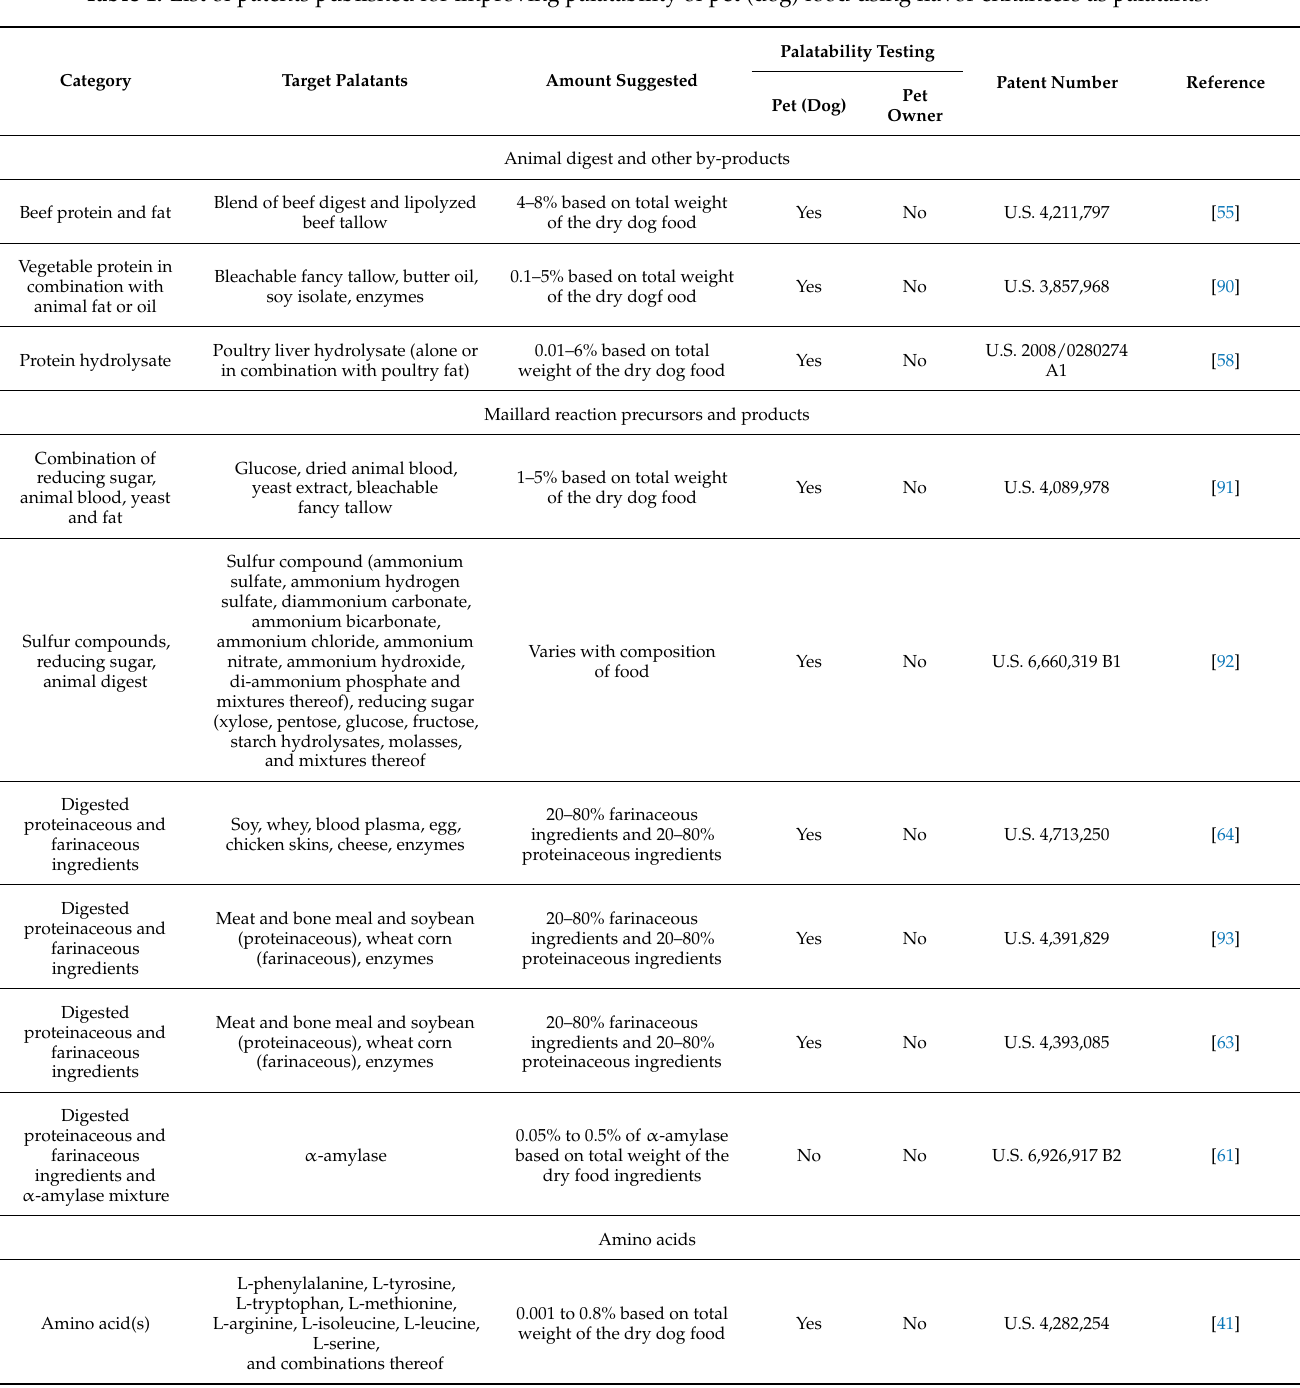
Table 1. List of patents published for improving palatability of pet (dog) food using flavor enhancers as